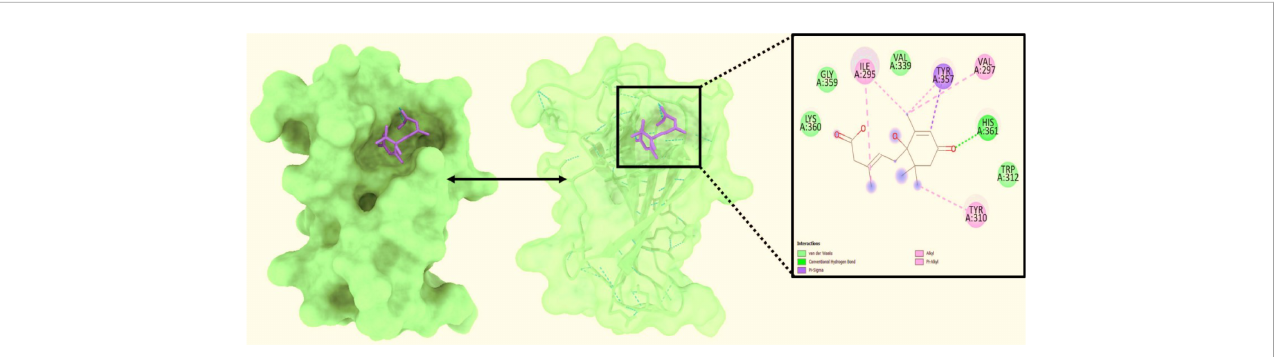
FIGURE 2 Analysis of the docked posture of 2AYD-643732; were displayed the ligand bound at the pocket of the receptor 2AYD and the binding pocket residues interacted with the ligand